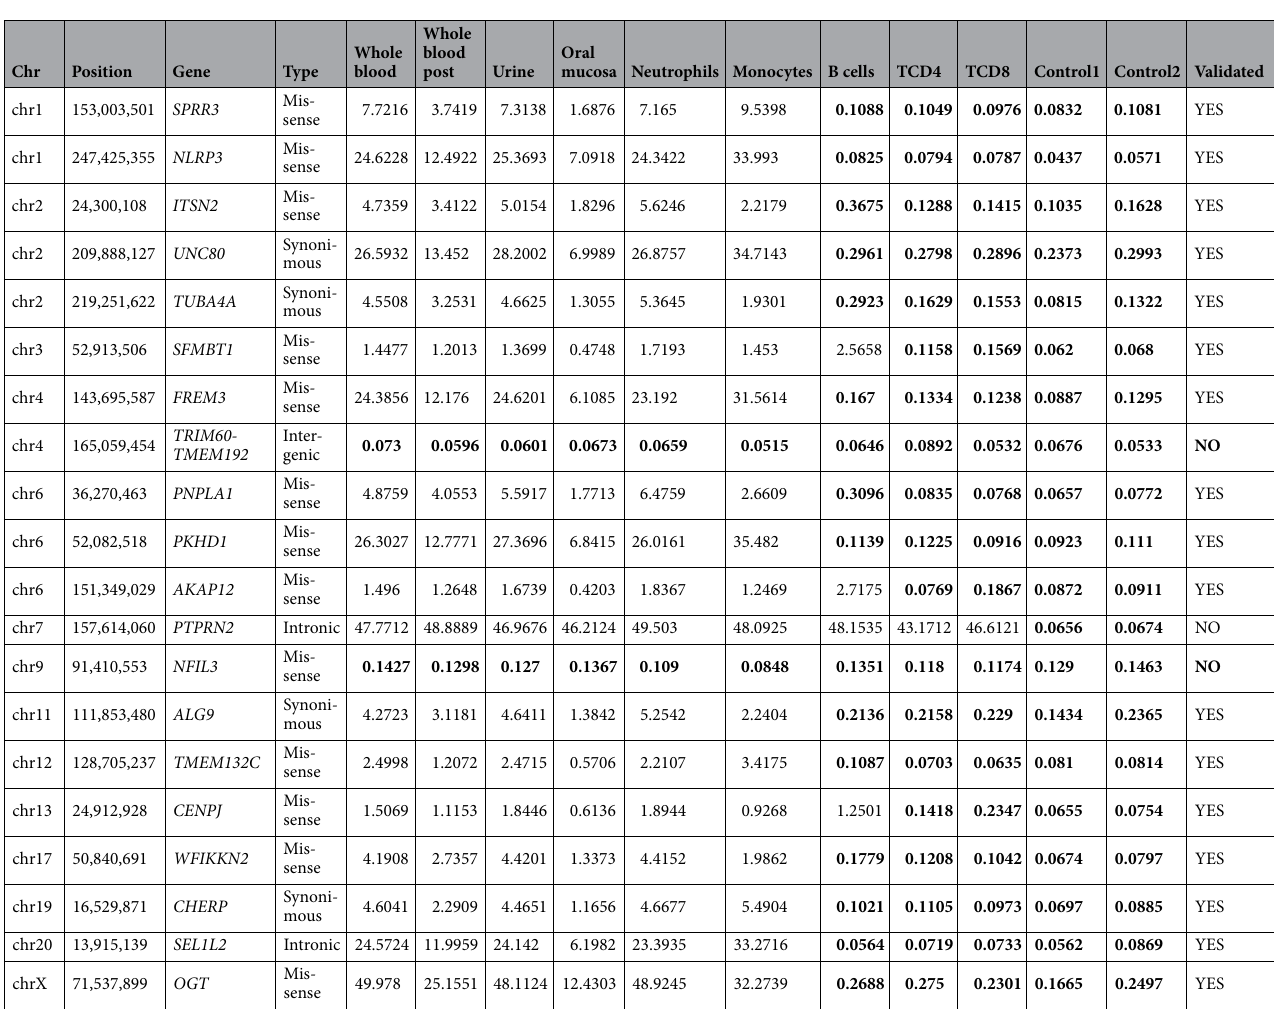
Table 3. VAF of the 20 somatic candidate variants studied in S5 patient. In bold, values below the sequencing error threshold.